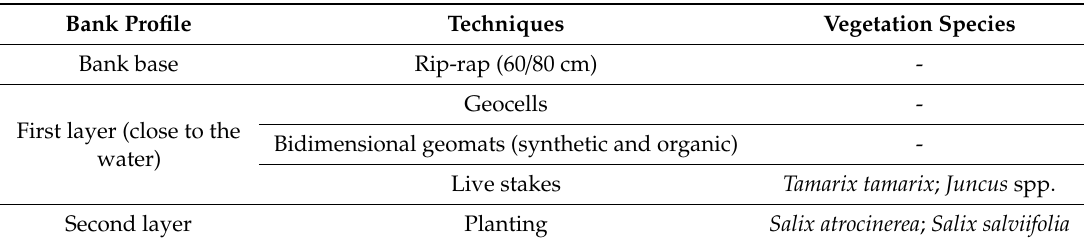
Figure 5 . Planned techniques and vegetation species along the bank profile designed for the Portuzelo site.